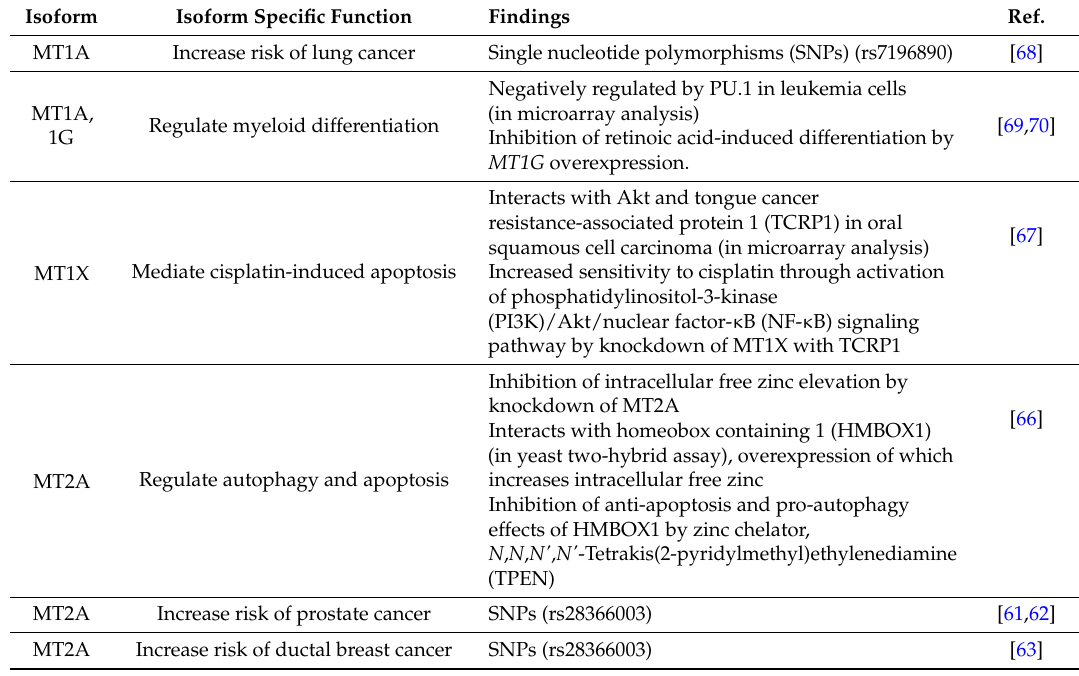
Table 2. Specific MT1/2 isoform